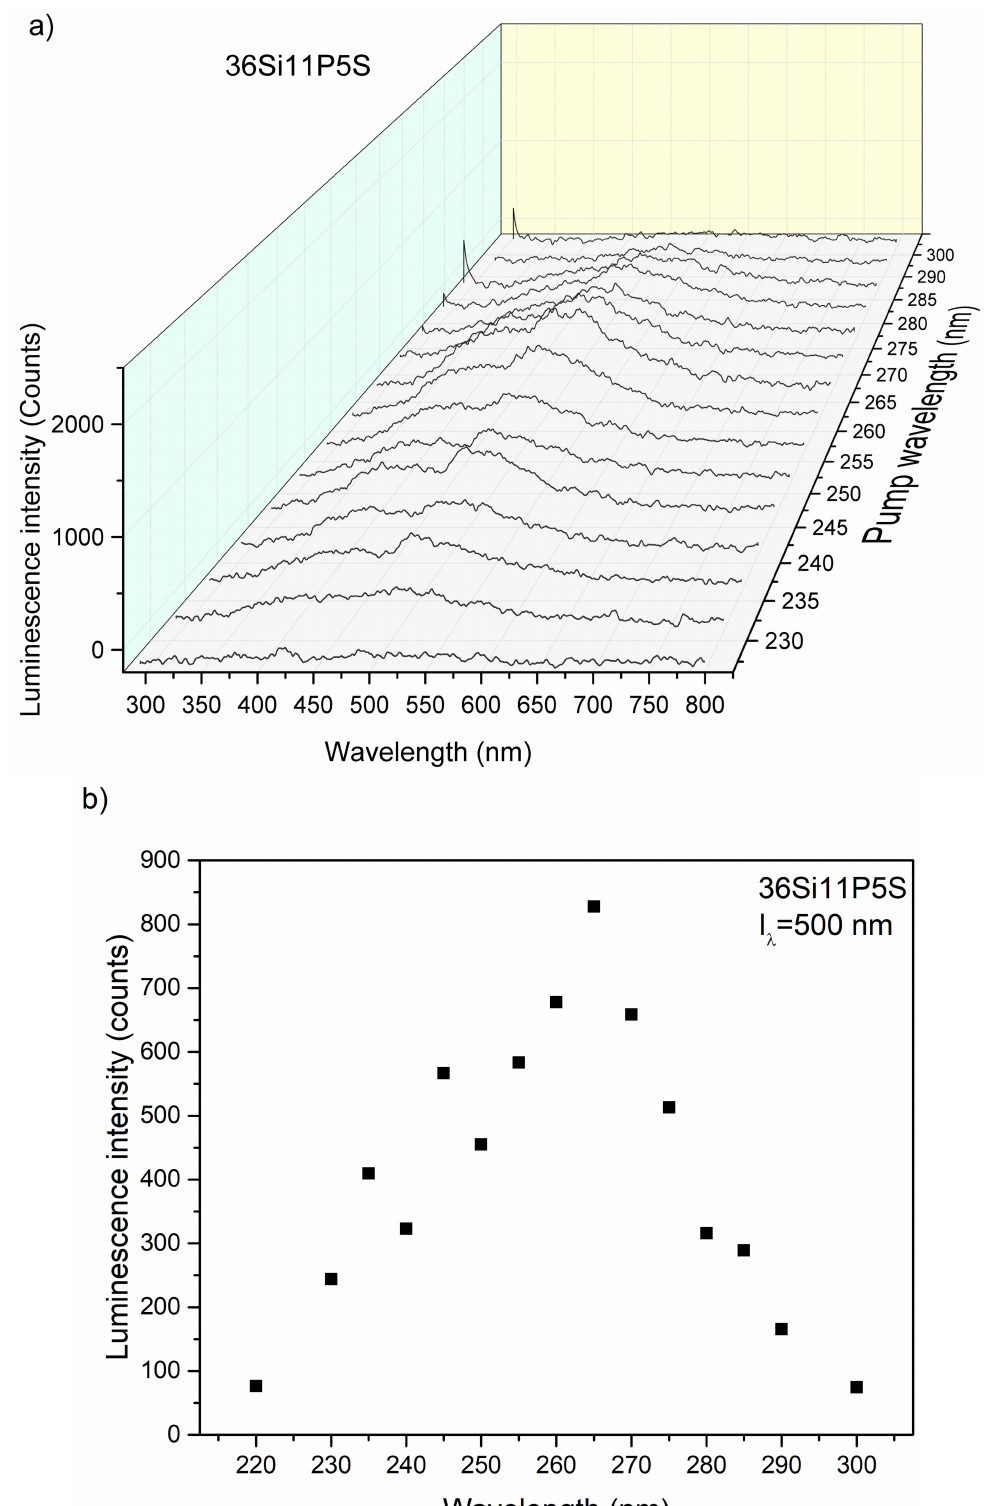
Figure 16. Luminescence intensity vs. wavelength and the laser pump ( a ) and luminescence intensity vs. wavelength at 500 nm ( b ) for the 36Si11P5S